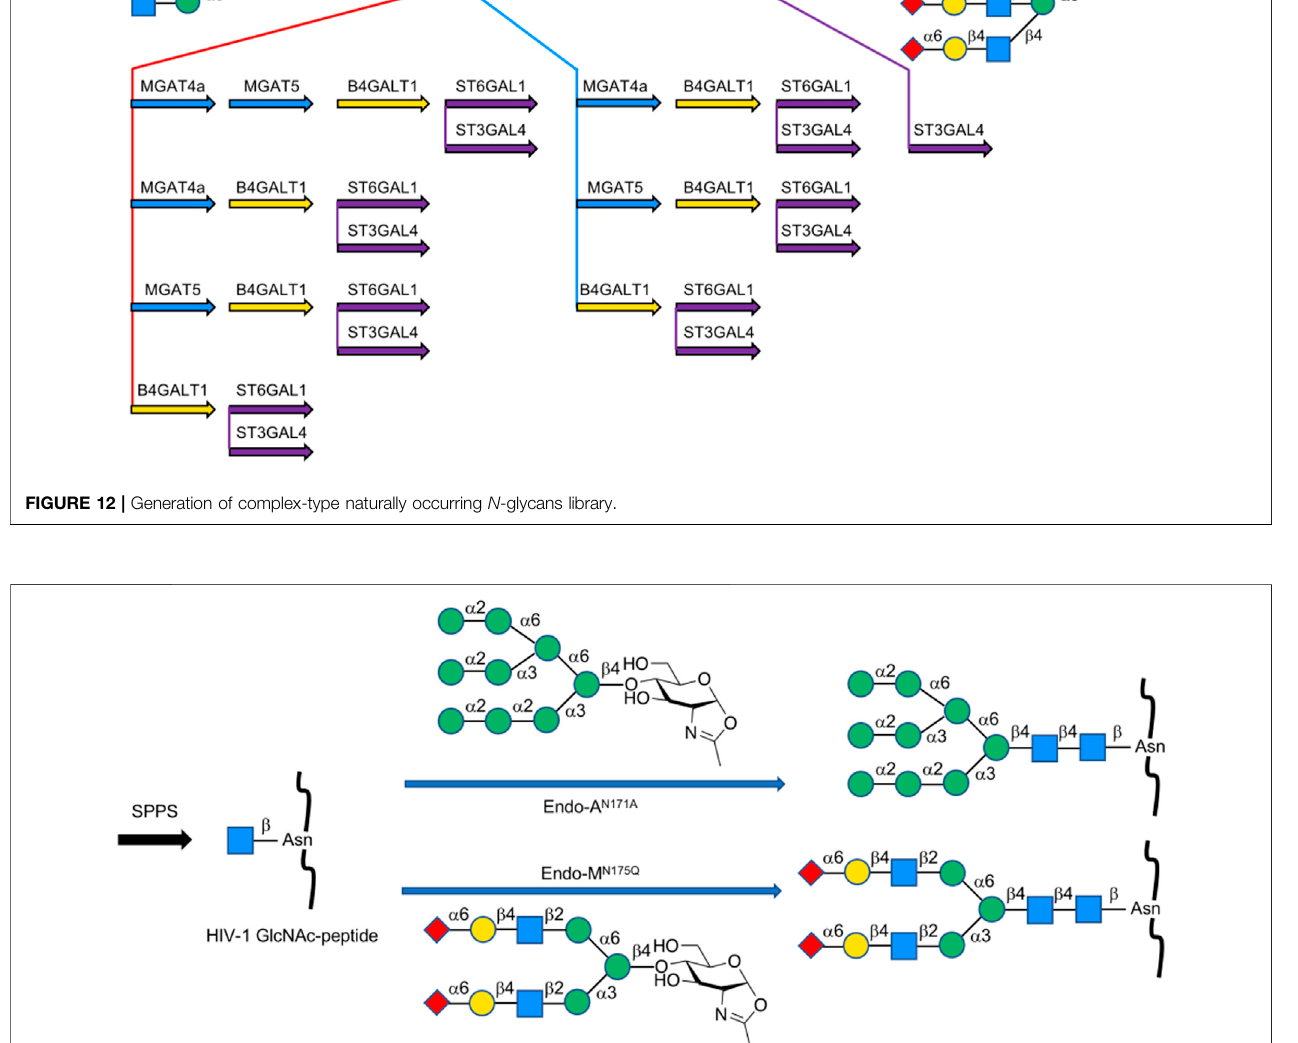
Frontiers in Chemistry |